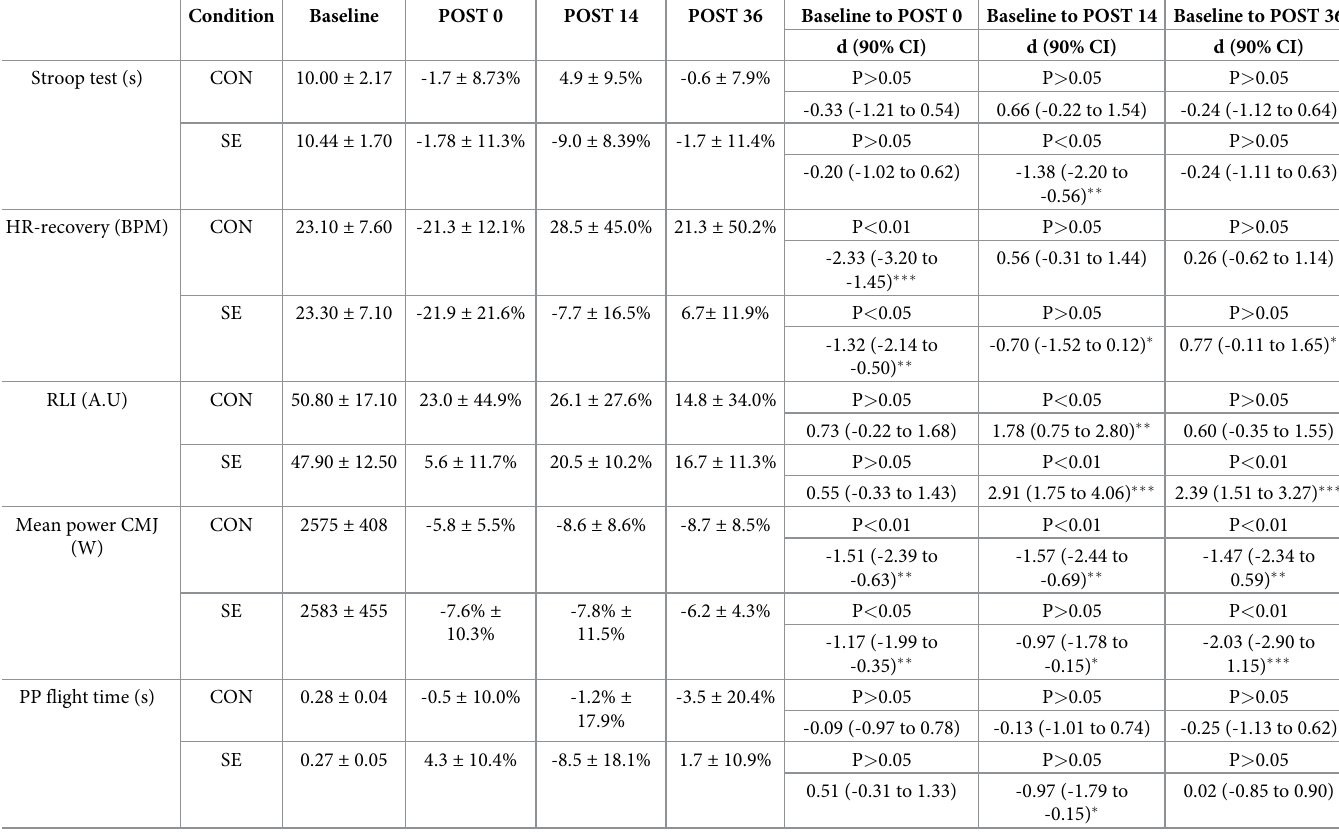
Table 5. Cognitive and physical markers change as percentage of